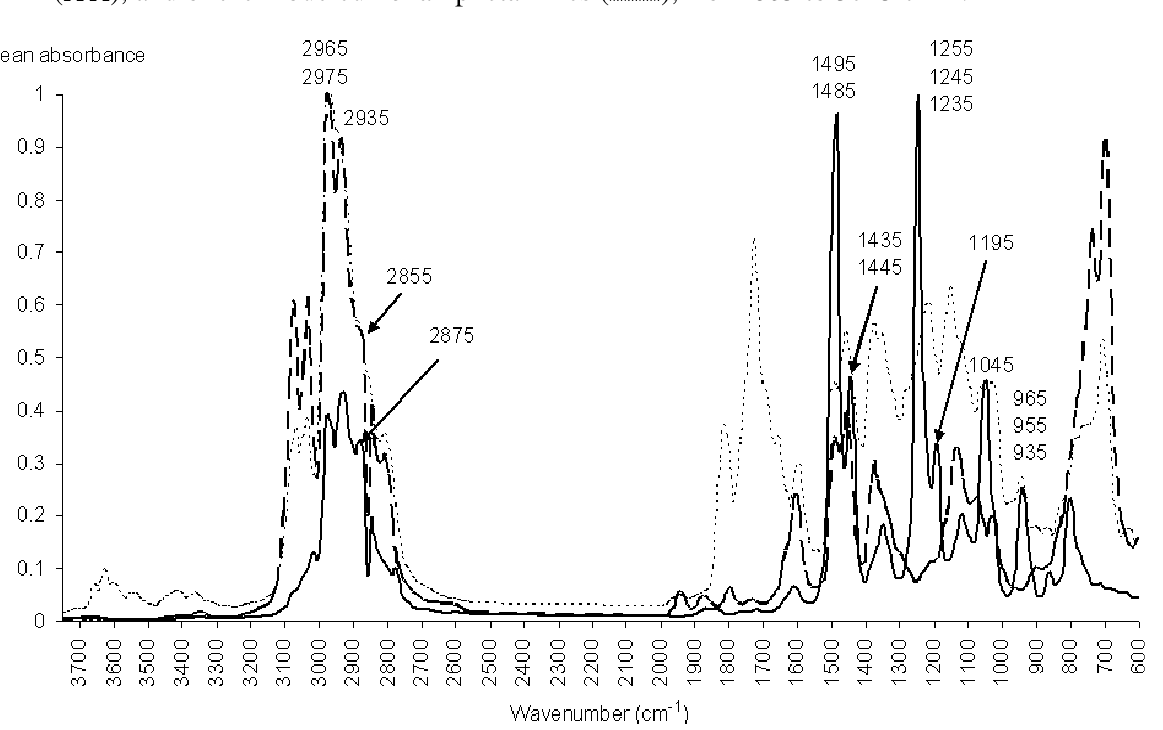
Figure 6. Mean spectrum of the modeled hallucinogens ( ), of the modeled stimulants ), from 605 to 3745 cm −1